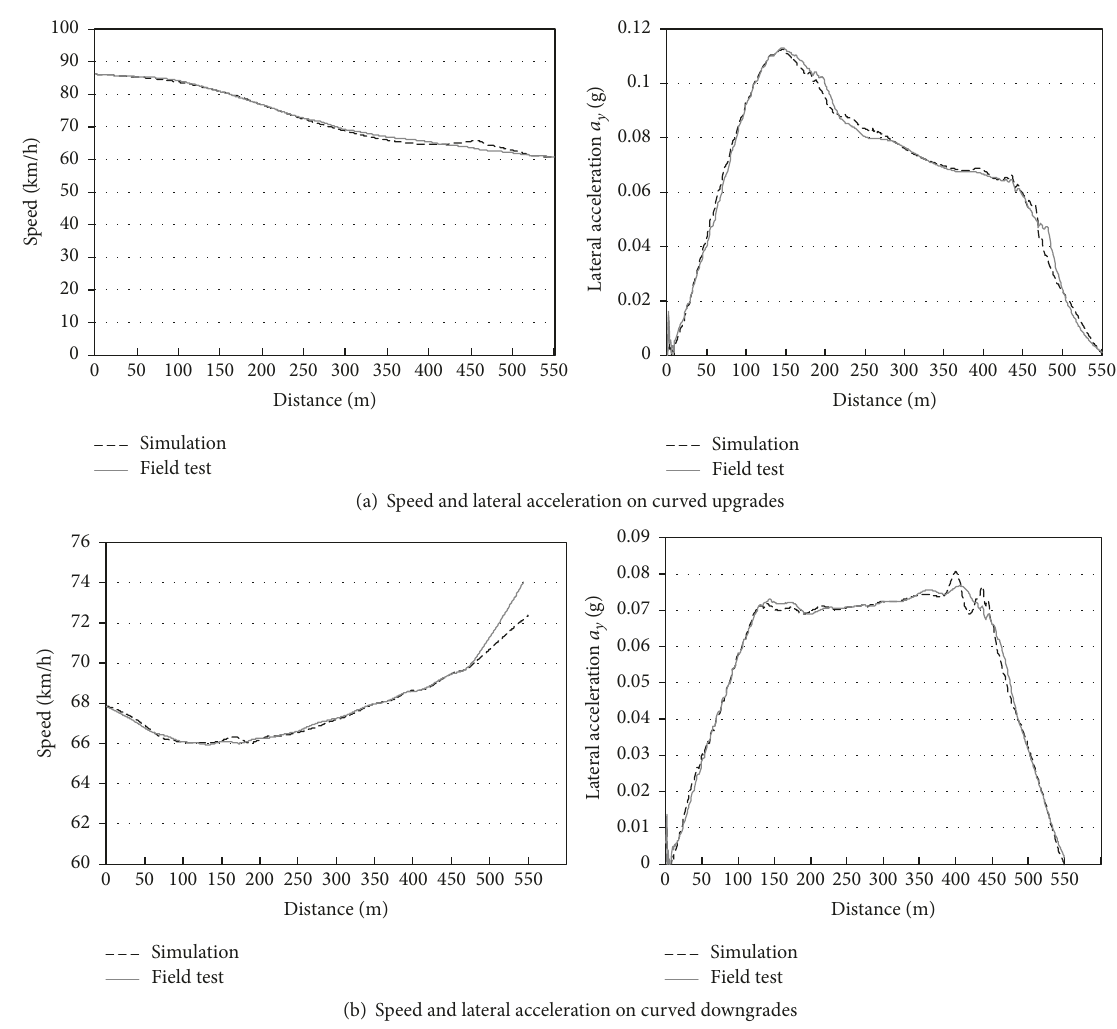
Figure 4: Comparison of simulated and measured results of typical freeway